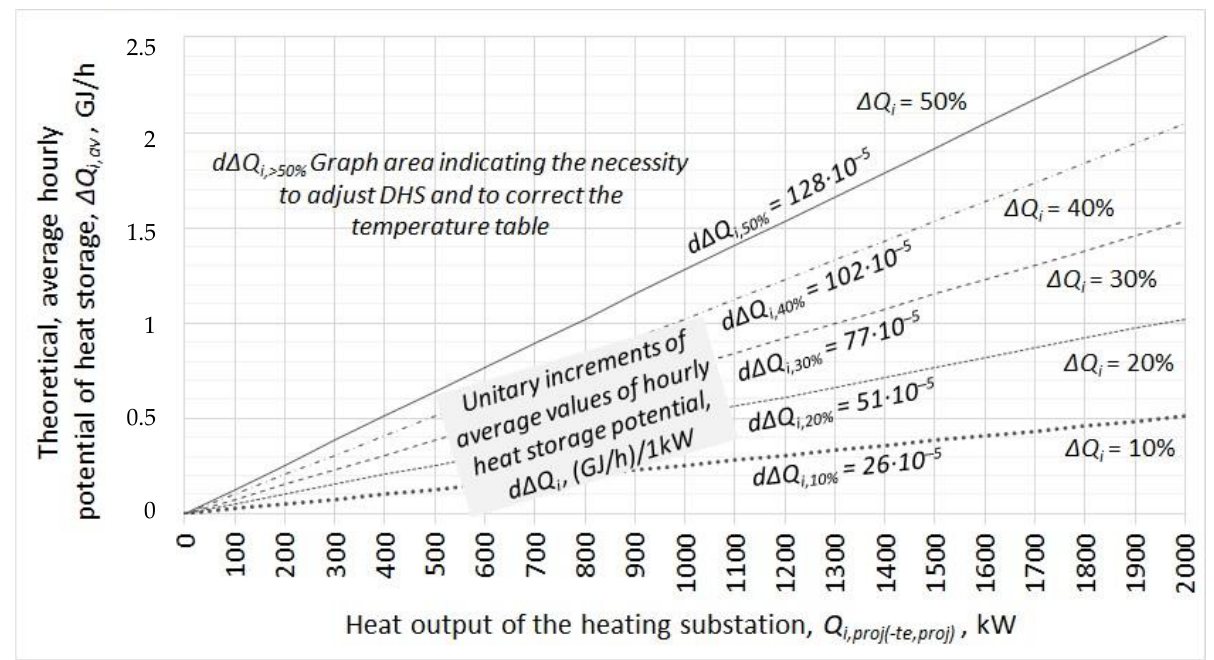
Figure 4 . Nomogram for the selection of theoretical, average hourly potential of heat storage . Figure 4. Nomogram for the selection of theoretical, average hourly potential of heat